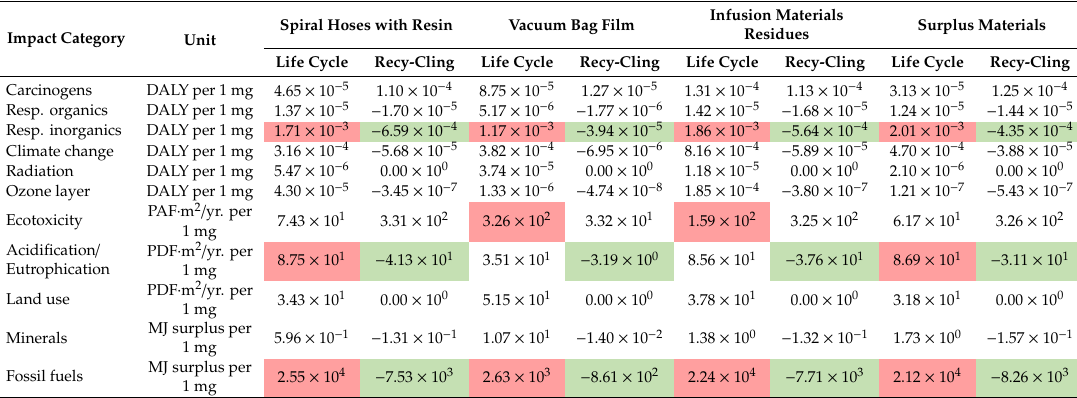
Red highlight—the highest level of negative environmental consequences for a given unit. Green highlight—the highest level of positive environmental consequences for a given